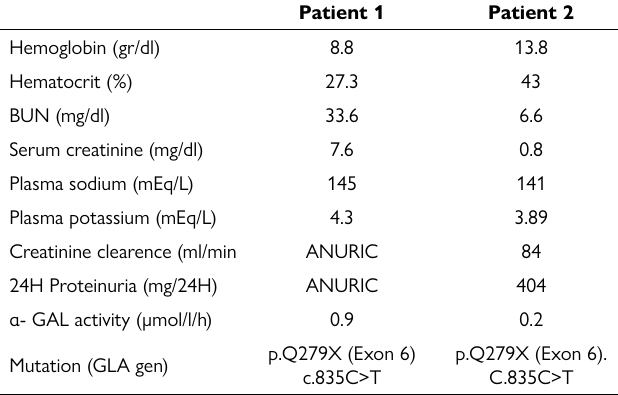
Table 1. Results of lab exams and molecular